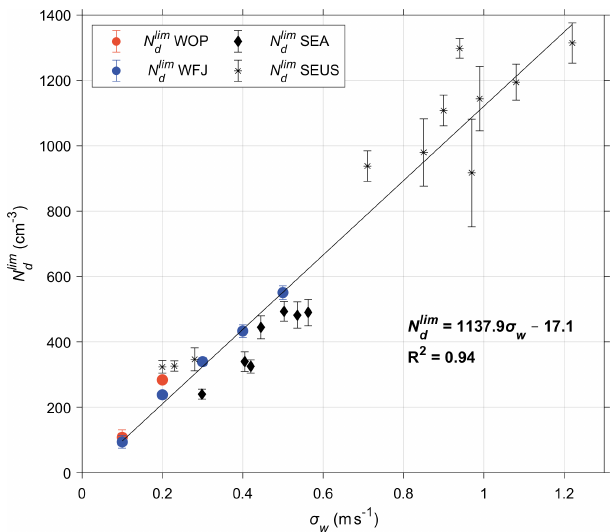
Figure 9. N lim (cm − 3 ) against σ w (ms − 1 ) calculated when d velocity-limited conditions are met at WOP (orange circles) and WFJ (blue circles) throughout the period of interest. Superimposed are the corresponding values calculated for clouds forming over the SEA Ocean (rhombuses) and over the SEUS (asterisks).